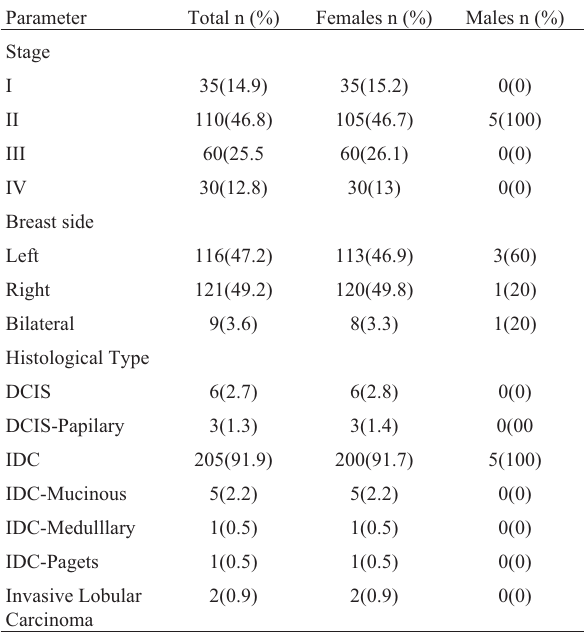
Table 2 - Clinical profile of breast cancer patients.